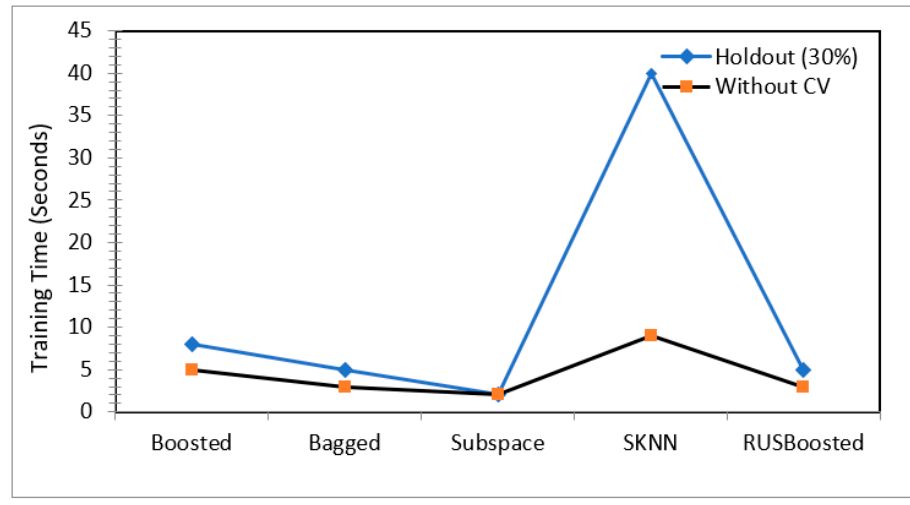
Figure 5. Training time comparison for various ensemble models with different CVs.